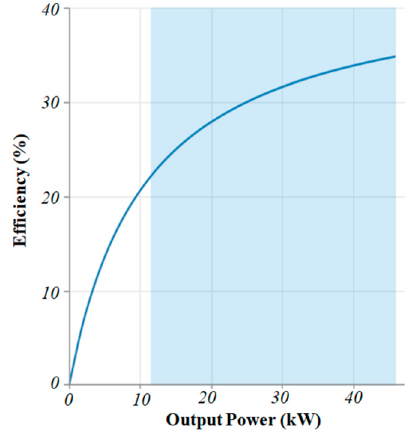
Figure 12. Efficiency curve of the diesel generator. Table 4. Technical details of the diesel generator.